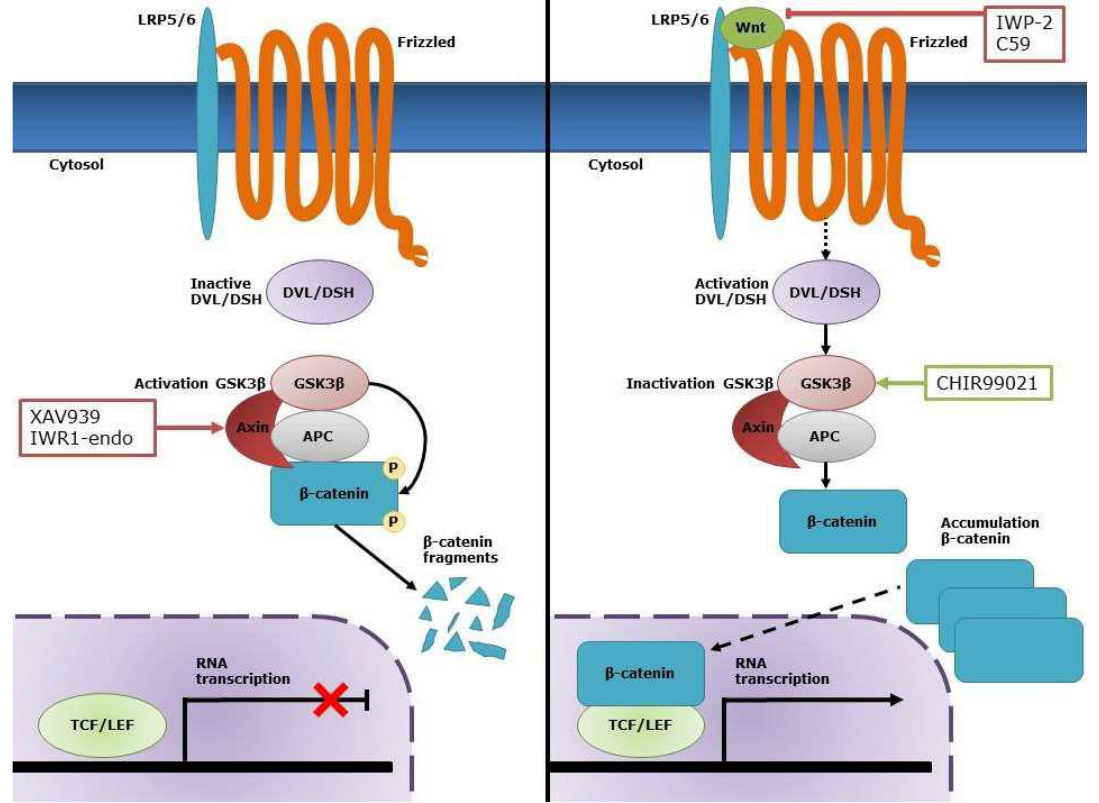
Figure 1. Overview of the canonical Wnt/β-catenin pathway. In the absence of Wnt, β-catenin is phosphorylated by the destruction complex consisting of Axin, adenomatous polyposis coli (APC), and glycogen synthase kinase (GSK)-3β, which leads to its degradation. In the presence of Wnt, this ligand interacts with its receptor complex consisting of low-density lipoprotein receptor-related protein 5/6 (LRP5/6) and Frizzled (FZD). This results in the activation of Disheveled (DSH) and subsequent inactivation of GSK-3β. As a result, β-catenin accumulates in the cytosol and translocates to the nucleus where it activates transcription of specific target genes through interaction with the T-cell factor/lymphoid enhancer factor (TCF/LEF) transcription factors. CHIR99021 is a selective inhibitor of GSK-3β and, therefore, increases the cytosolic levels of β-catenin, which allows nuclear translocation of active β-catenin. C59 and IWP2 are both inhibitors for Wnt production and secretion, while XAV939 and IWR1-endo inhibit Wnt signaling via stabilization of the APC/Axin/GSK-3β destruction complex of β-catenin.